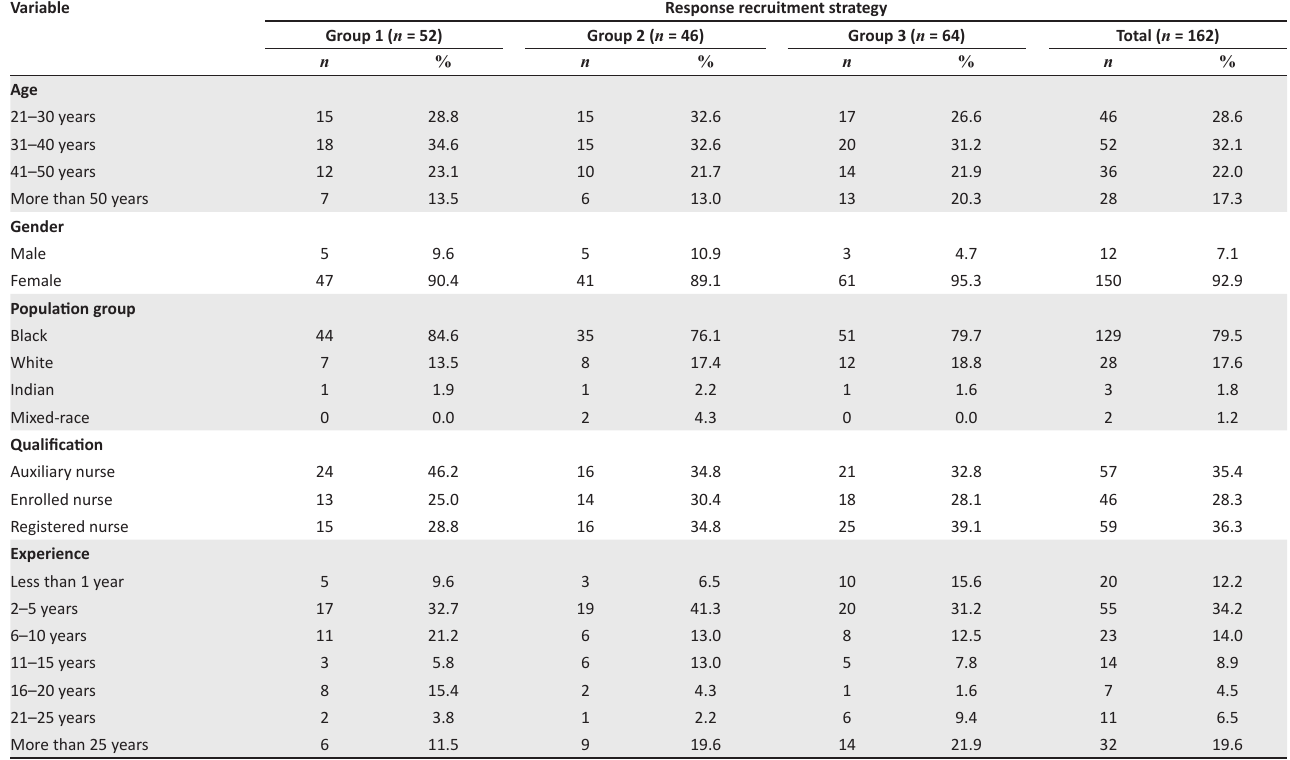
TABLE 1: Socio-demographic characteristics by recruitment strategy used.